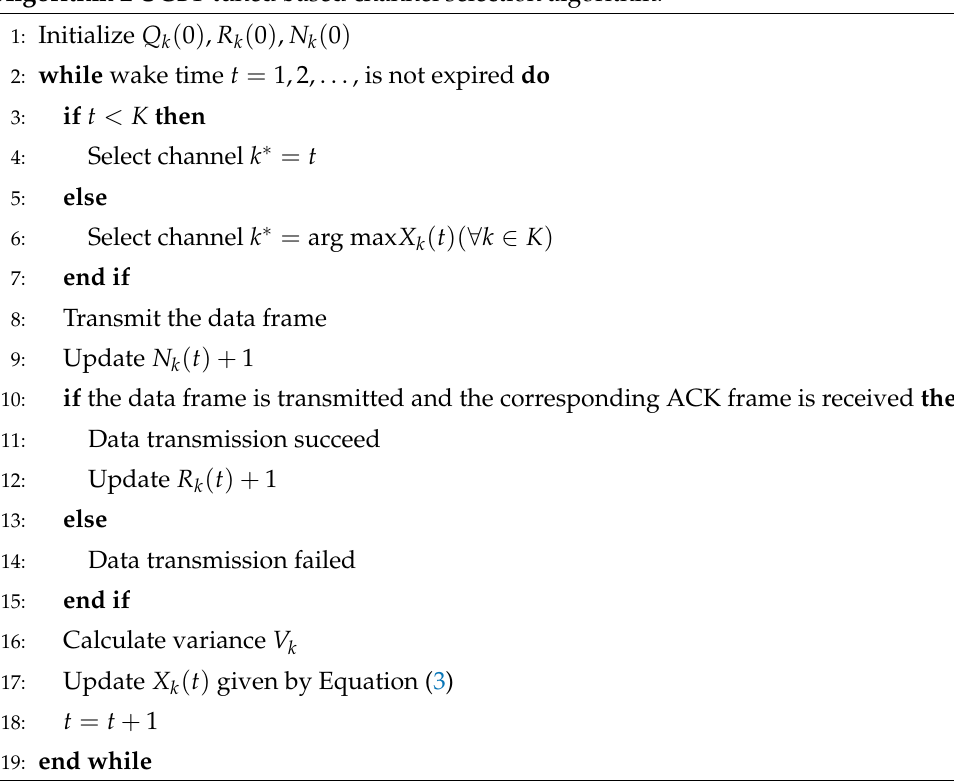
Algorithm 2 UCB1-tuned based channel selection